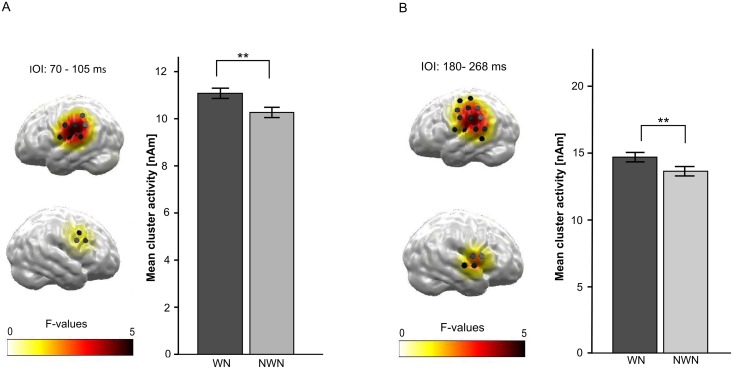
Results for the main effect of noise type in the bilateral temporal region of interest (ROI) for the two different intervals of interests (IOI).Only regions surviving cluster-based permutation are colorized. F-values corresponding to a corrected p < .05(A) or p < .01. (B) Black cylinders indicate the locations of dipoles selected as the temporal ROI.** p < .01. (A) Left: Statistical parametric map of F-values for the main effect noise type averaged between 70 and 105 ms. Right: Corresponding mean ROI activity for the test tone (TT) after white noise (WN, black) and after notched white noise (NWN, grey). Bars denote within-subject 95%-confidence intervals. (B) Left: Statistical parametric map of F-values for the main effect noise type averaged between 180 and 268 ms. Right: Corresponding mean ROI activity evoked by the TT after WN (back) and after NWN (grey). Bars denote within-subject 95%-confidence intervals.